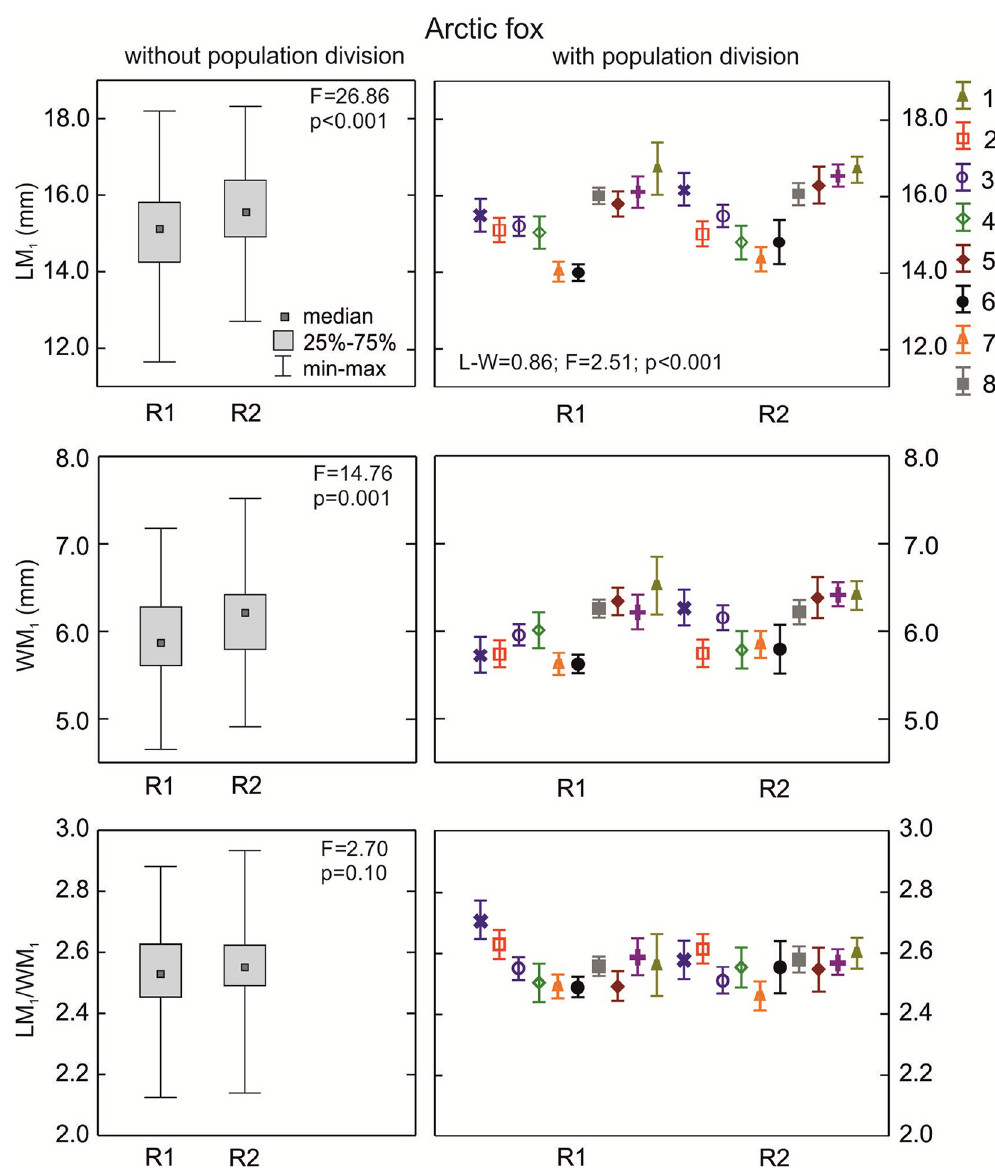
Fig 11. Comparison of median values for length, width, and size proportion of M 1 between various group R morphotypes in the red fox with and without population division. Illustrations of group R morphotypes are shown in Fig 2. Information about the samples can be found in Table